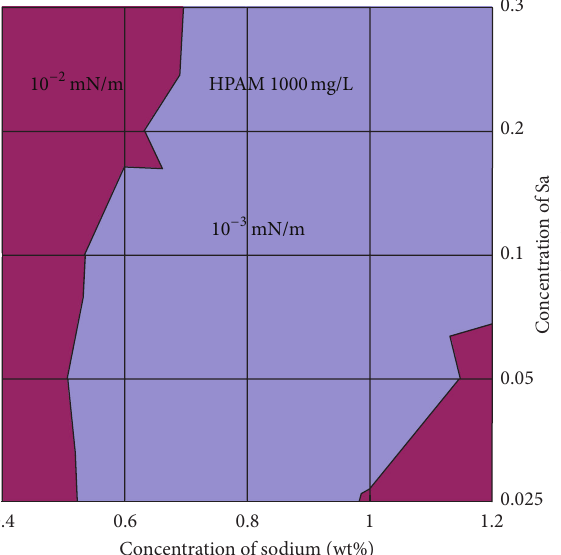
Figure 4: Interfacial tension of the ASP flooding system containing HPAM.